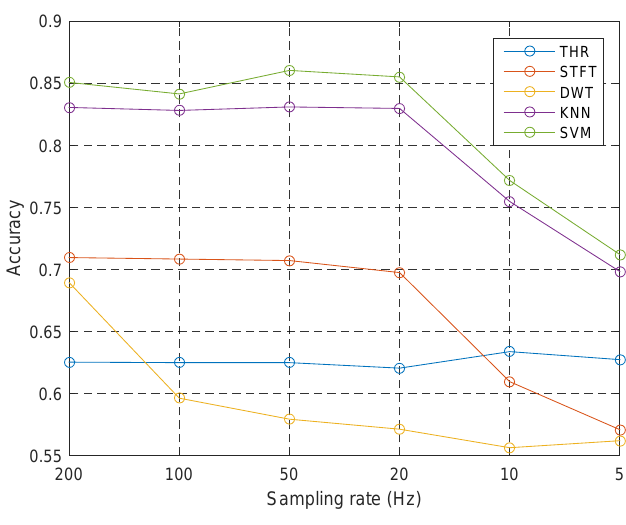
Figure 7. Context effects: sampling